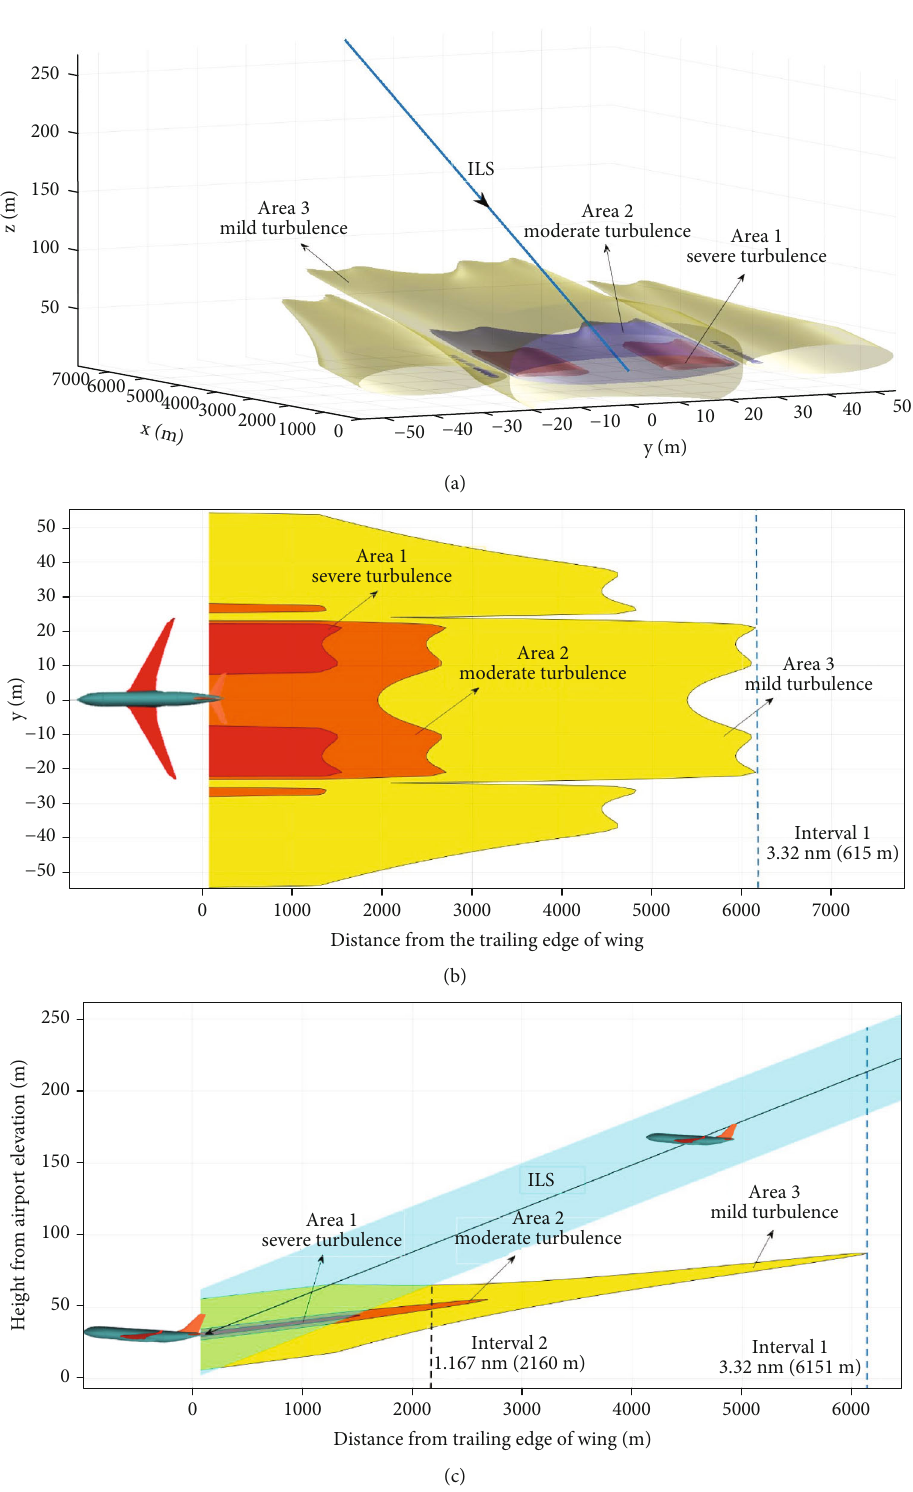
Figure 18: Overload hazard area. (a) Hazardous area isosurface; (b) the top view of the hazard zone; and (c) the side view of the hazard